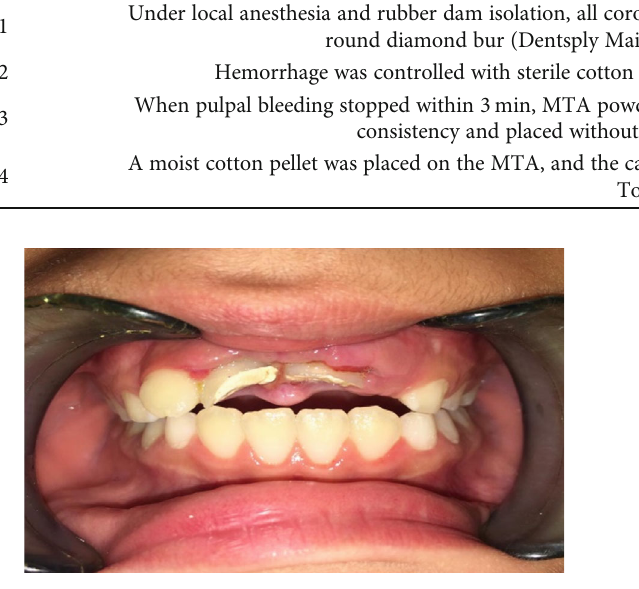
Figure 3: Cervical pulpotomy white MTA for both incisors.